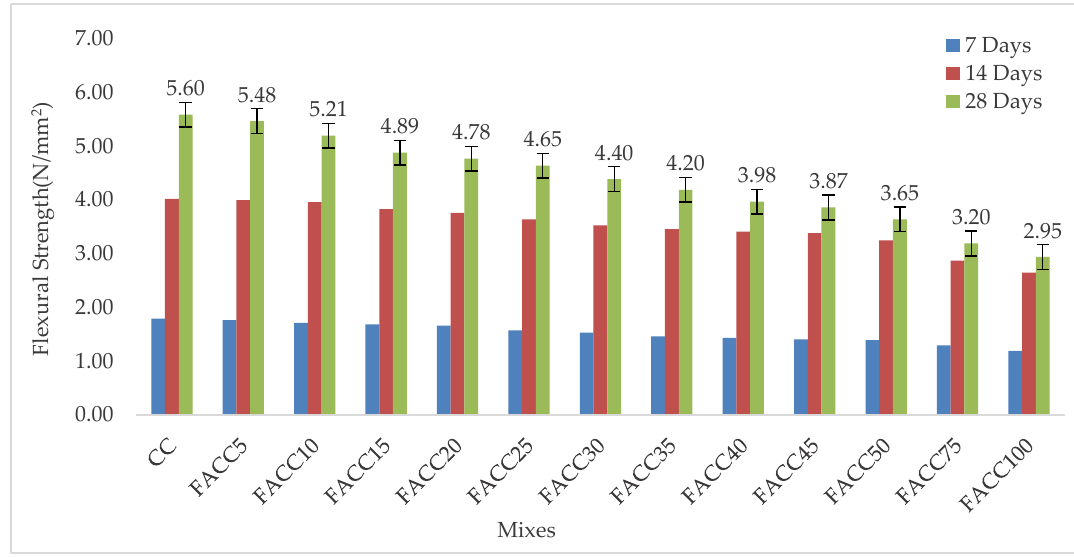
Figure 7. Variation of Flexural Strength with Age for CC and FACC.